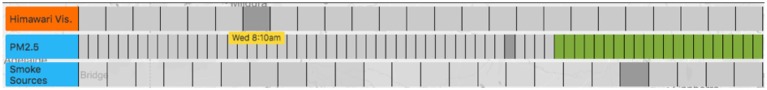
The time track provides a simple and intuitive mechanism for synchronizing and displaying time-series data from different sources while maintaining a simple representation of the data available. The entire time track represents the total duration available with each block representing a single time step. Hovering over a time step displays the time and blocks in other time tracks with coincident times are highlighted.